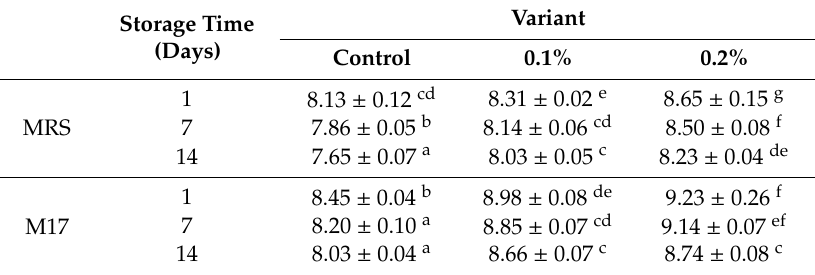
Table 4. Total viable counts (log10 CFU g − 1 ) in yoghurts supplemented with of 0.1% and 0.2% ( w / v ) of Rosa spinosissima fruits extract during 14 days of